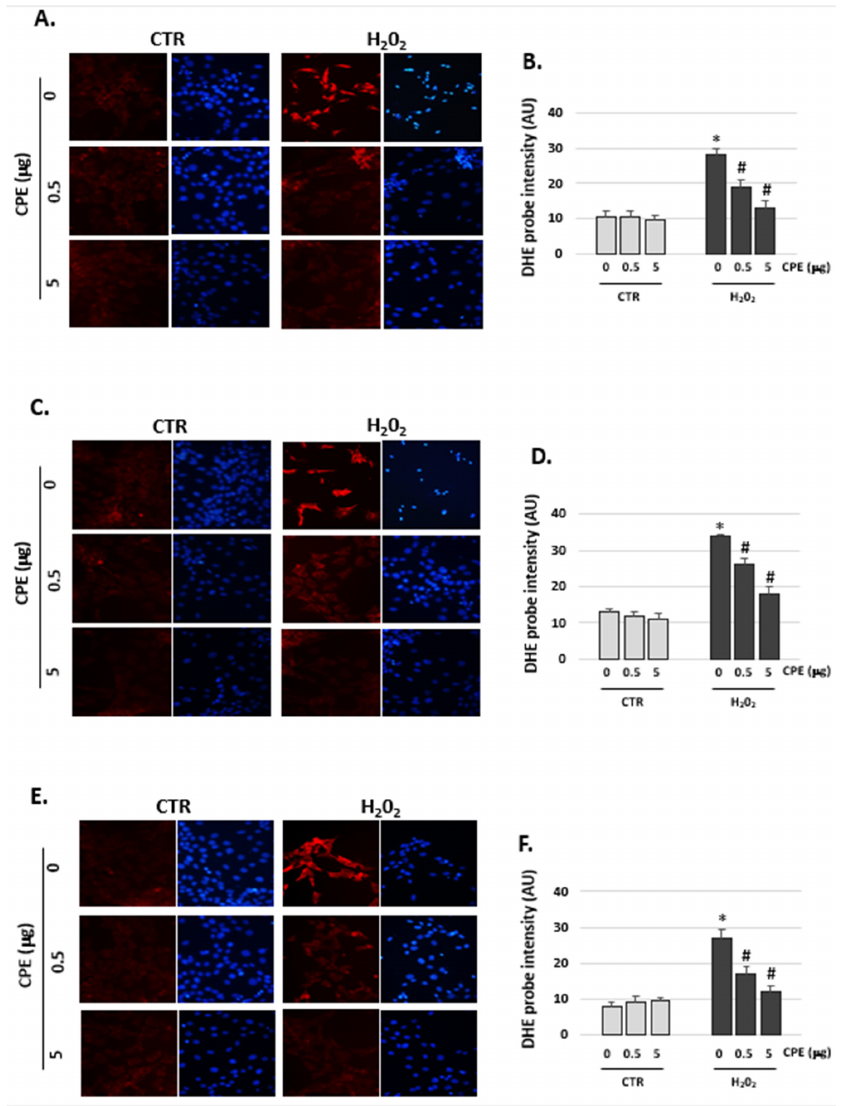
Figure 4. Cocoa decreased the production of ROS in senescence auditory cells. Representative images of fluorescence micrographs of ( A ) HEI-OC1, ( C ) OC-k3 and ( E ) SV-k1 cells (×40). ROS de- tection with the fluorescent probe dihydroethidium, DHE (red fluorescent), and DAPI (a marker of cell nuclei with blue fluorescent) dye in cell cultures at the end of the experiments. Experimental groups: CTR group (0; 0.5 and 5 μ g/mL of CPE) and H 2 O 2 group (induced cellular senescence with 100 μ M for 1 h in all groups: 0; 0.5 and 5 μ g/mL of CPE).Quantification of fluorescence intensity for